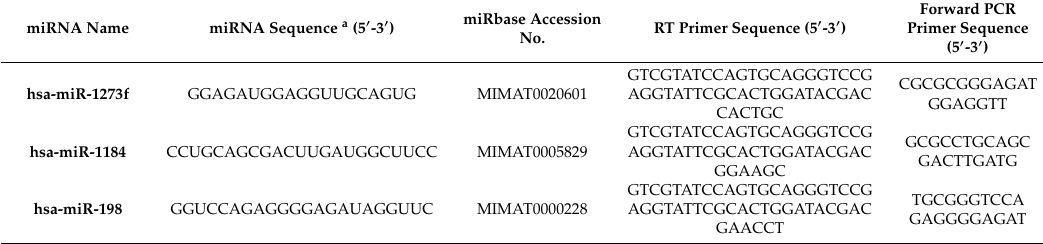
Table 2. Specific miRNA primers for